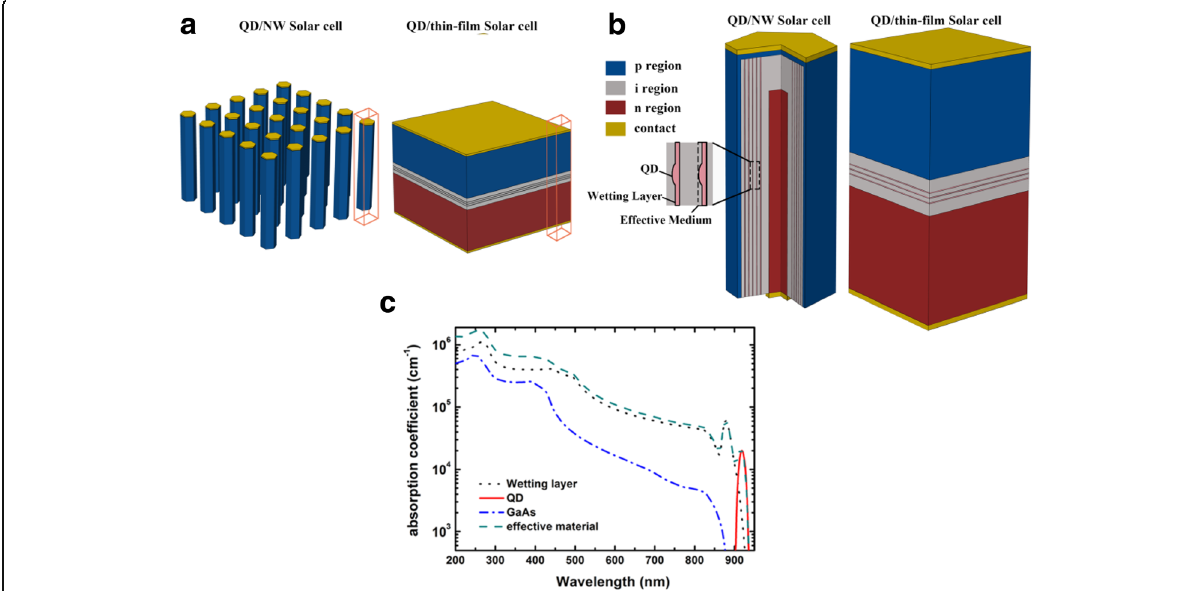
Fig. 1 a The schematic drawings of the NW/QD hybrid solar cell and its thin-film counterpart. b The detailed structures of the units marked with wireframes in a . c Absorption coefficient of the effective medium. The volume fractions of QDs, WL, and GaAs in the effective medium